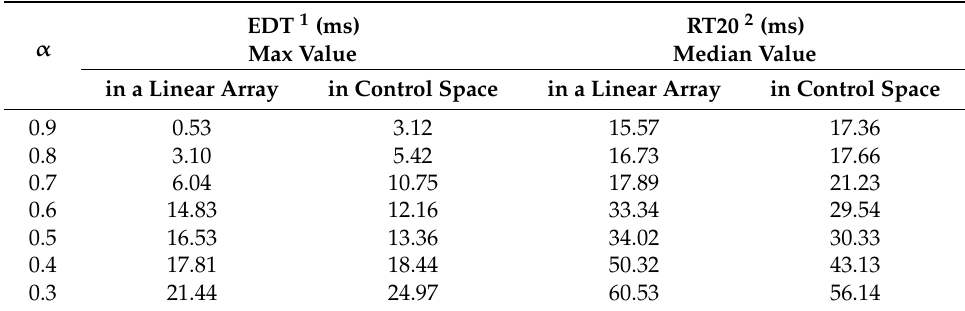
Table 2. Simulation results of acoustic parameters to confirm the operating conditions of the active localization